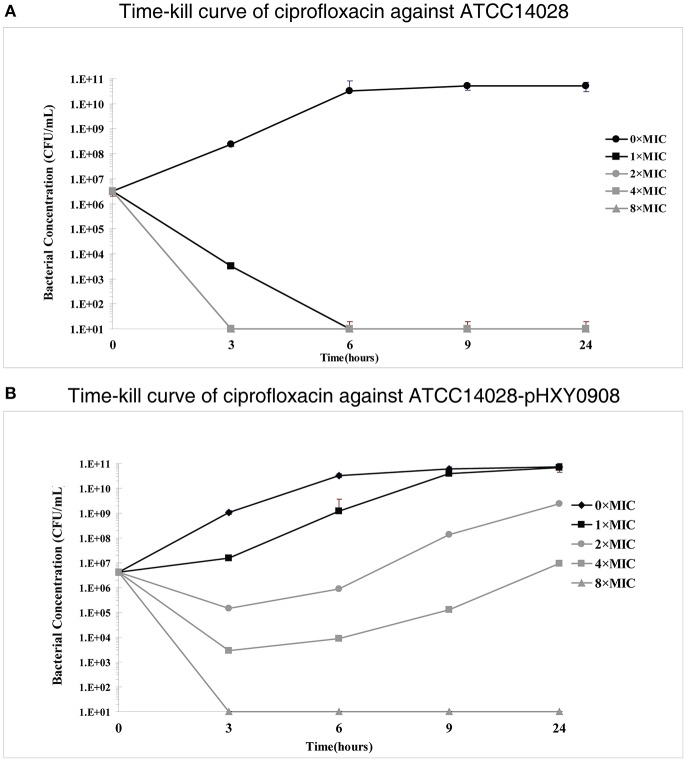
In vitro time-kill studies of ciprofloxacin (A)
Salmonella Typhimurium ATCC14028 and (B) and ATCC14028-pHXY0908 1 × MIC is equivalent to 0.03125 mg/L for ATCC14028 and 0.125 mg/L for ATCC14028-pHXY0908. The lines and markers of 2 × MIC and 8 × MIC coincided with 4 × MIC in (A).